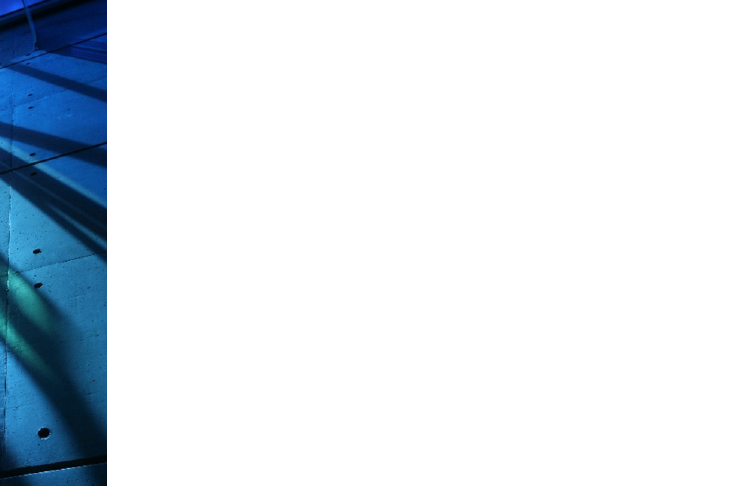
Figure 10. Close up of skylight with view to dichroic lens mounted on wall (Credit: Scott Norsworthy).